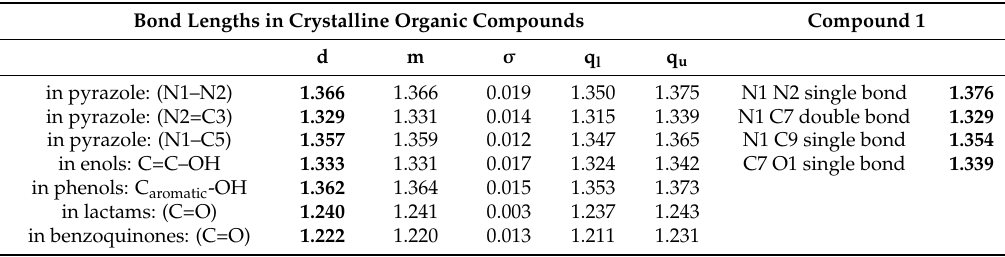
Table 4. Proof of the bond length for the position of H at O1